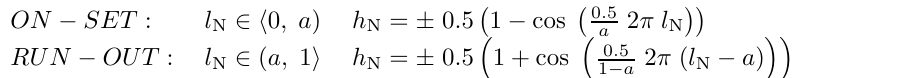
Fig. 7. Fitting of asymmetric COS obstacle shapes separately for OS/RO branches: (a) CC + B; (b) CC + P, using estimates of a (mean ( ), median ( ), modus